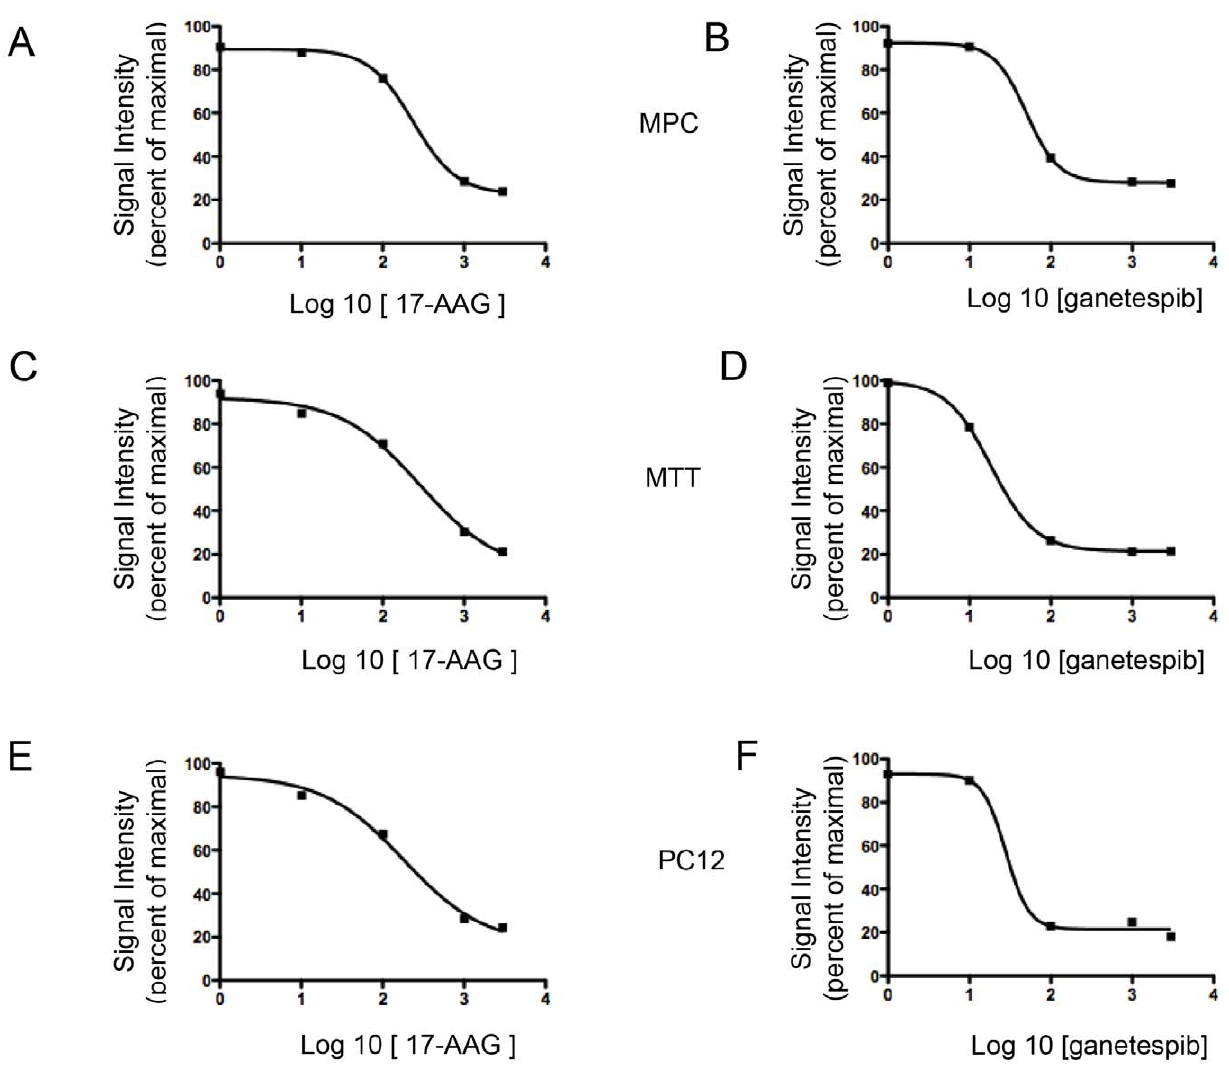
Figure 1. 17-AAG and ganetespib inhibit cellular proliferation in pheochromocytoma cell lines. A and B) MPC cells, C and D) MTT cells, and E and F) PC12 cells were treated with different concentrations of 17-AAG or ganetespib (from 1 nM to 1 m M) and incubated for 48 hours. The graph represents the dose-response of log 10 concentrations of 17-AAG or ganetespib versus signal intensity in a thiazolyl blue formazan (MTT)-based assay.